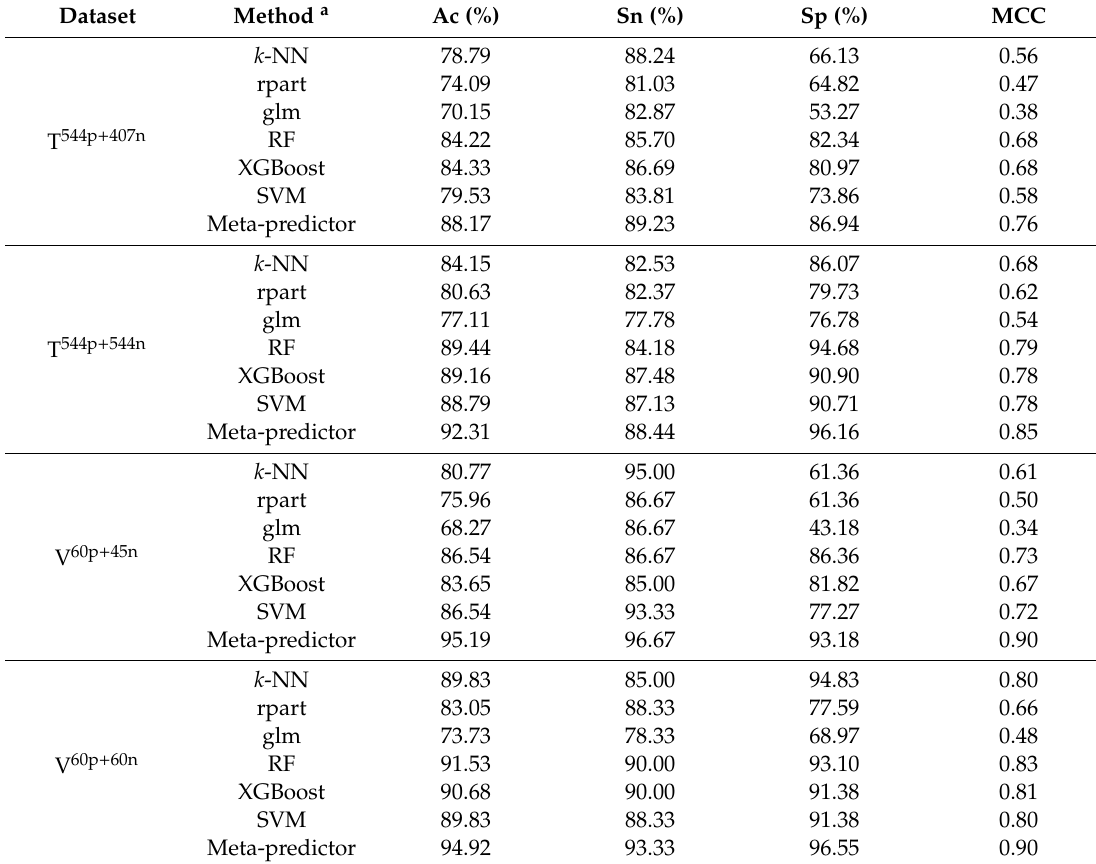
Table 4. Performance comparisons between Meta-iAVP and the six machine learning algorithms as assessed by the five-repeated five-fold cross-validation and independent validation